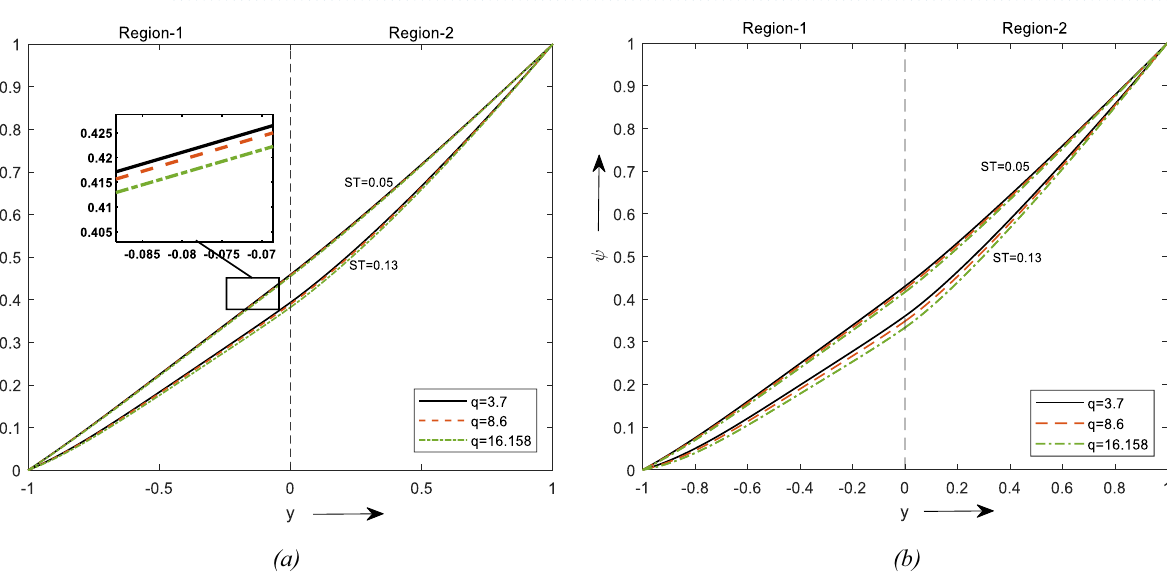
Figure 6. Concentration profiles for different values of Sc. ( a ) For two different values of φ . ( b ) For a value of φ .